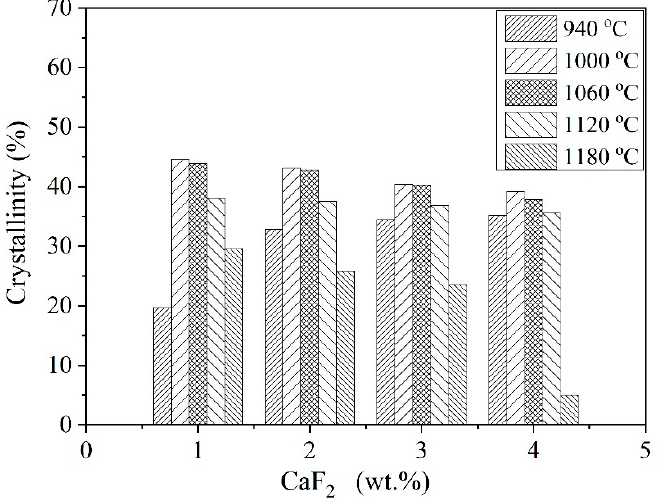
Figure 4. The crystallinity of wollastonite glass-ceramics calculated by Rietveld refinement from the XRD